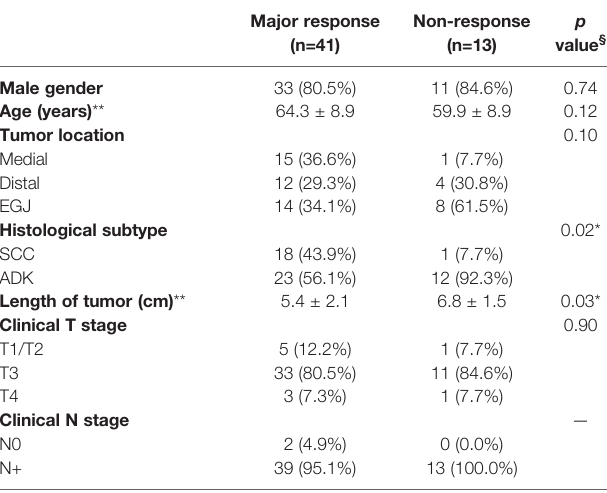
TABLE 1 | Baseline features with signi fi cance of association to treatment